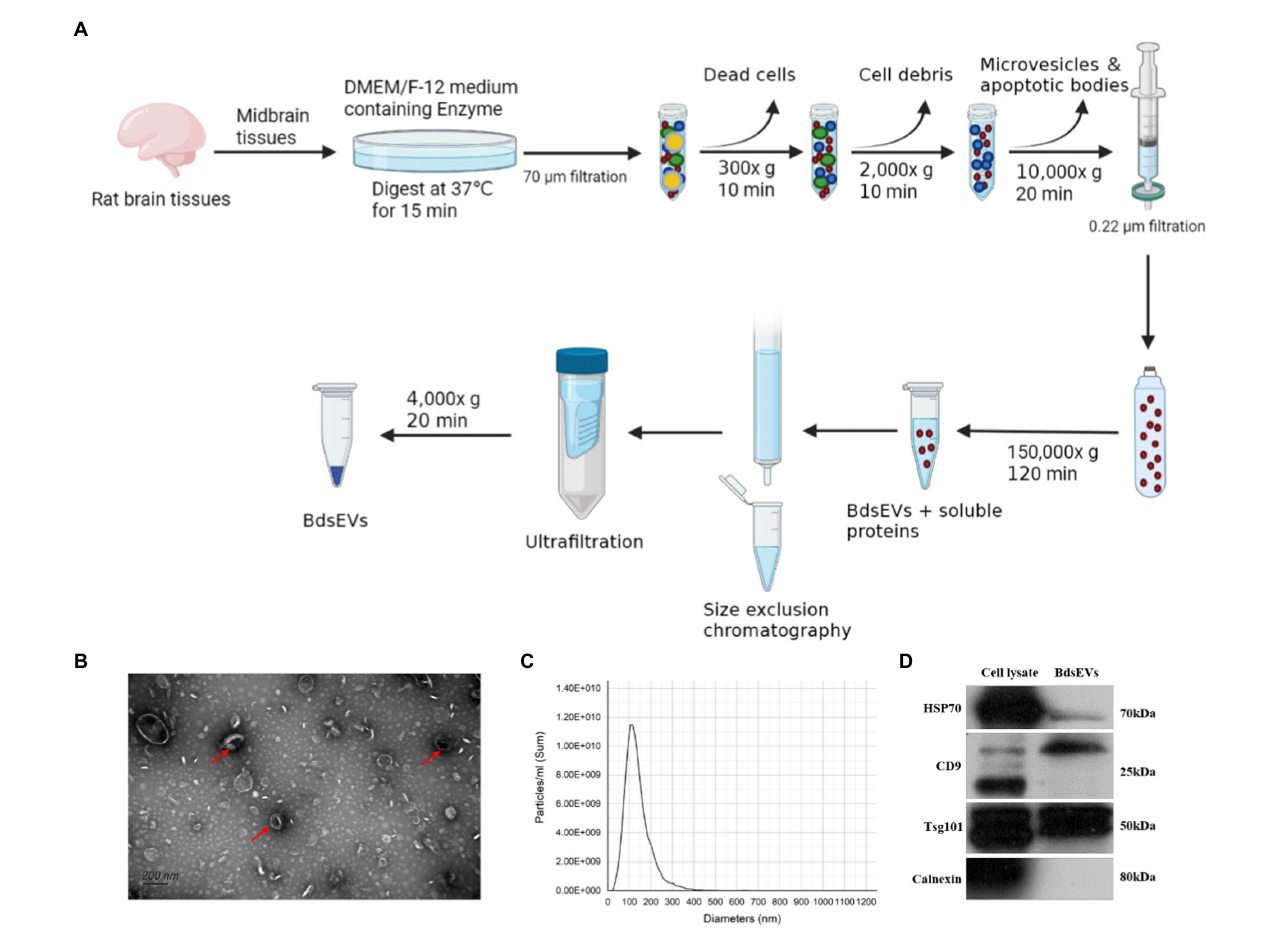
FIGURE 2 Isolated midbrain tissue–derived sEVs (bdsEVs) enriched fractions. (A) Isolation overview, (B) Transmission electron microscopy (TEM) images of bdsEVs, (C) Nanoparticle tracking analysis (NTA) of bdsEVs, and (D) sEVs positive markers HSP70, CD9, and TSG101; negative marker calnexin of bdsEVs enriched fractions isolated from the midbrain. sEVs, small extracellular vesicles; HSP70, heat-shock protein 70; CD9, cluster of differentiation 9; TSG101, tumor susceptibility gene